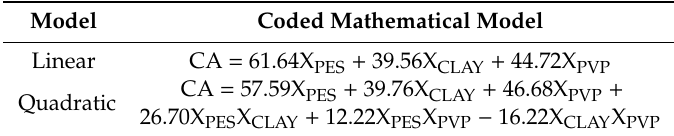
Table 6. Coded mathematical models: linear and quadratic for the contact angle.